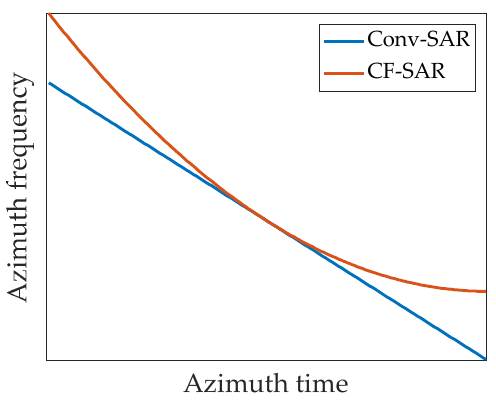
Figure 5. Azimuth TFD of Conv-SAR and CF-SAR.